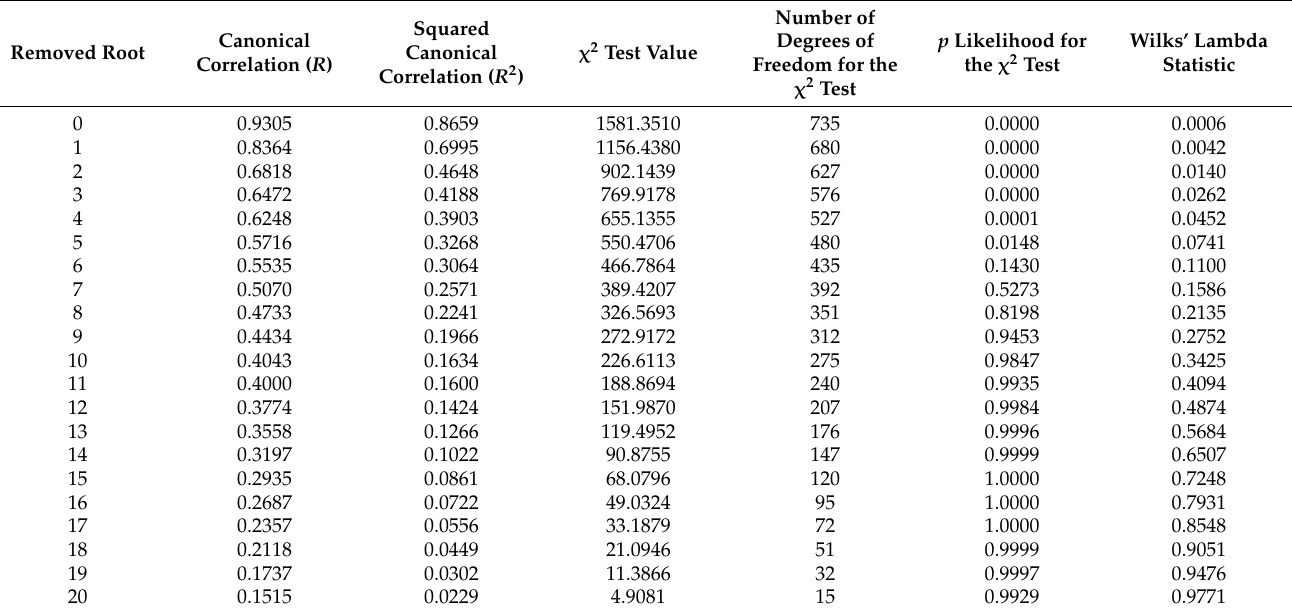
Table 7. Results of the Wilks’ lambda